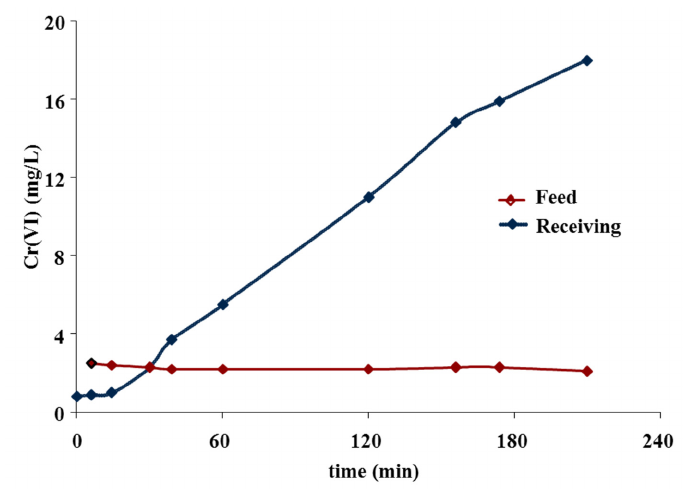
Figure 4. Variation in the Cr(VI) concentration (mg/L) in the feed solution (in continuous supply) and the receiving solution (in recirculation, 10 mL) at the outlet of the contactor. Membrane [( − )-DMEB] = 30 mM, membrane solution volume = 50 mL; [Cr(VI)] = 2.5 mg/L; receiving [HNO 3 ] = 0.75 M.